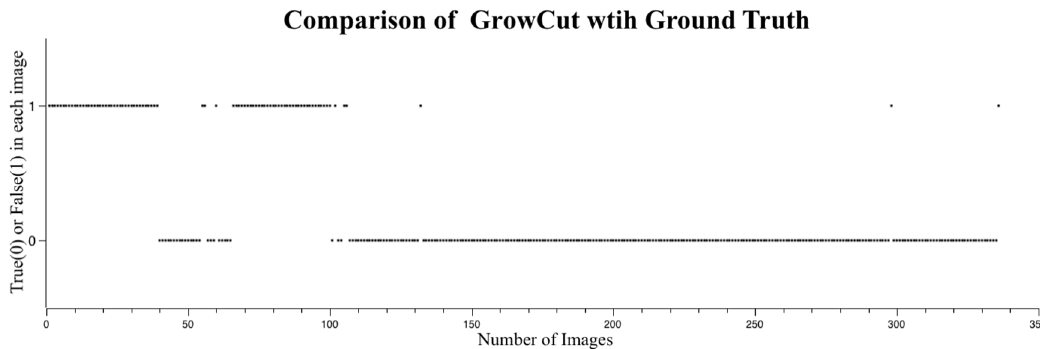
Figure 12. Segmentation success or failure with GrowCut. True (0) indicates success, and False (1) indicates failure. Most false detections occurred between Images 0–40 and Images 70–100 with heavy rain and fog. However, GrowCut was more robust to raindrop stains on the CCTV screen (after Image 100).